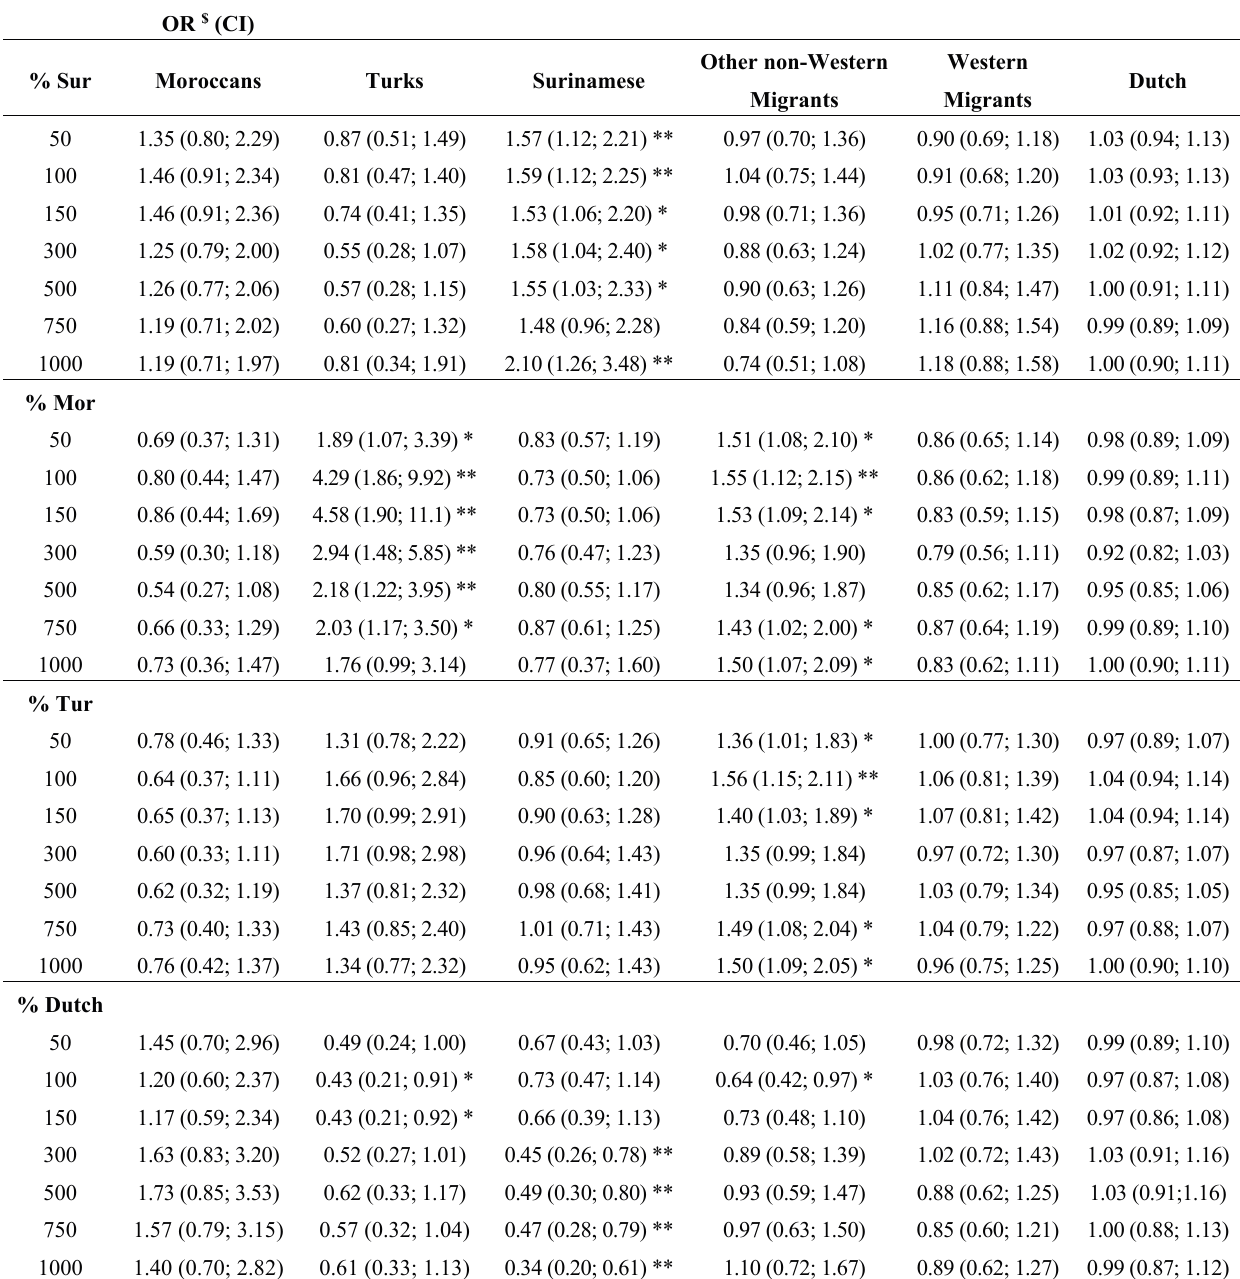
Table 4. Association presence of other ethnic groups with poor self-rated health, per ethnic group and spatial scale (Model